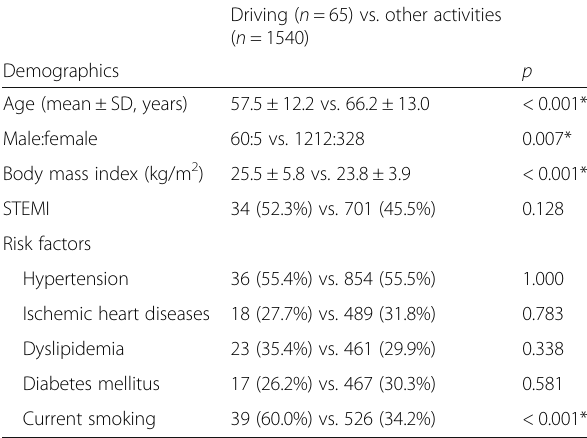
Table 1 Comparison of variables between patients who sustained ACS while driving and those who sustained ACS while performing other